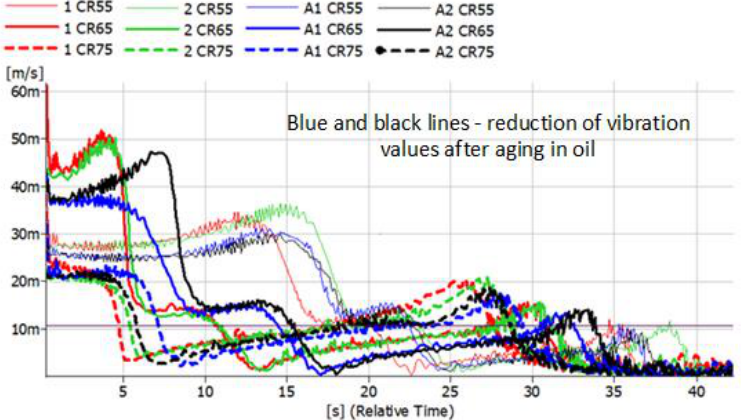
Figure 12. Vibration parameters during the run-down process with CR rubber absorbers installed in the vibration insulation system.